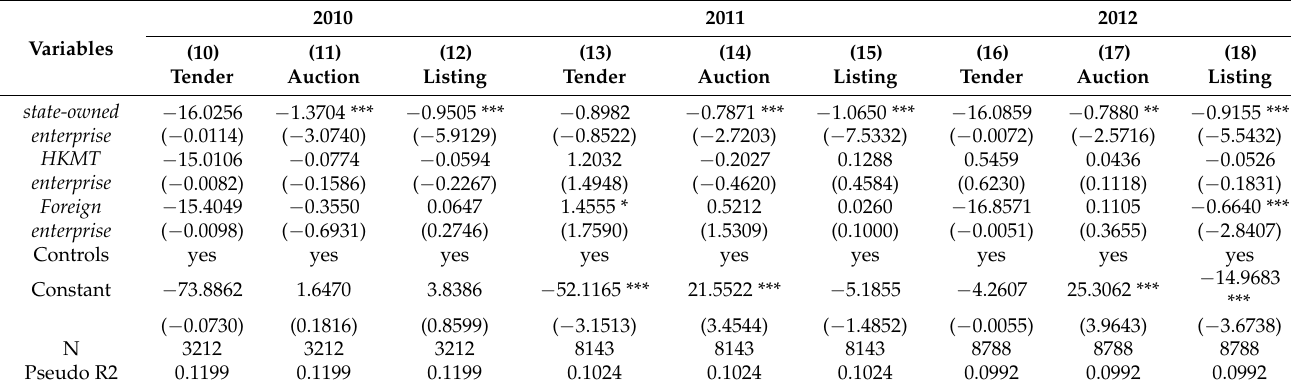
Table A2. Results of mlogit model considering types of enterprises (2010–2012).